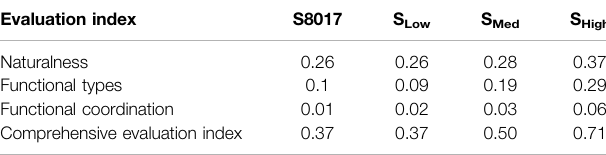
TABLE 8 | Comprehensive evaluation index